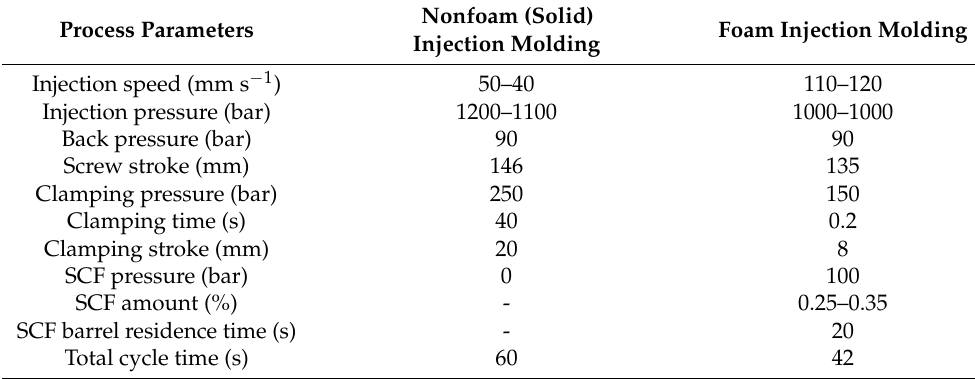
Figure 2. Schematic representation of ( a ) Method 1 and ( b ) Method 2. Table 1. Foam injection molding process